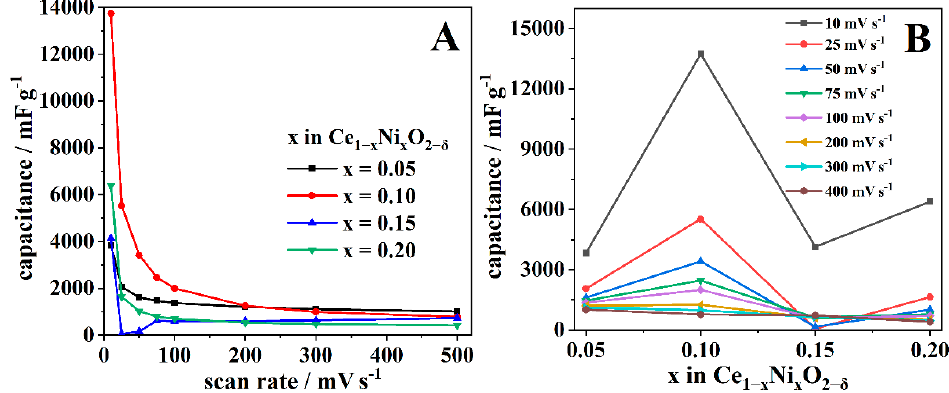
Figure 1. Specific capacitance values plotted as a function of the ( A ) potential scan rate and ( B ) electrode composition (lines are a guide for the eye).